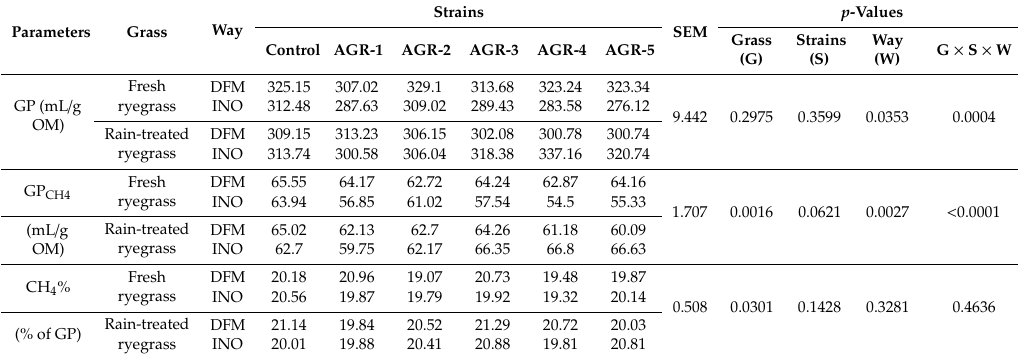
Table 3. E ff ect of LAB strains on gas and methane